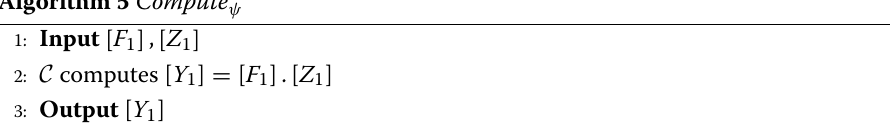
Algorithm 5 Compute ψ